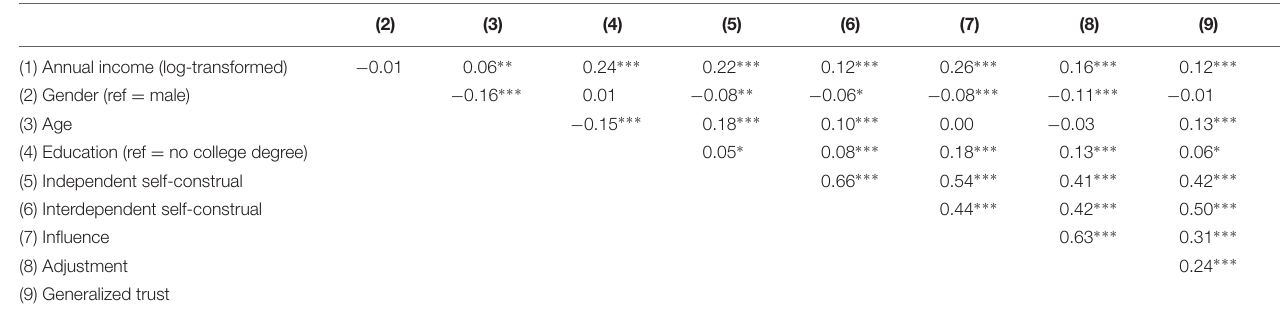
TABLE 1 | Zero-order correlations between individual-level variables (Pearson’s r